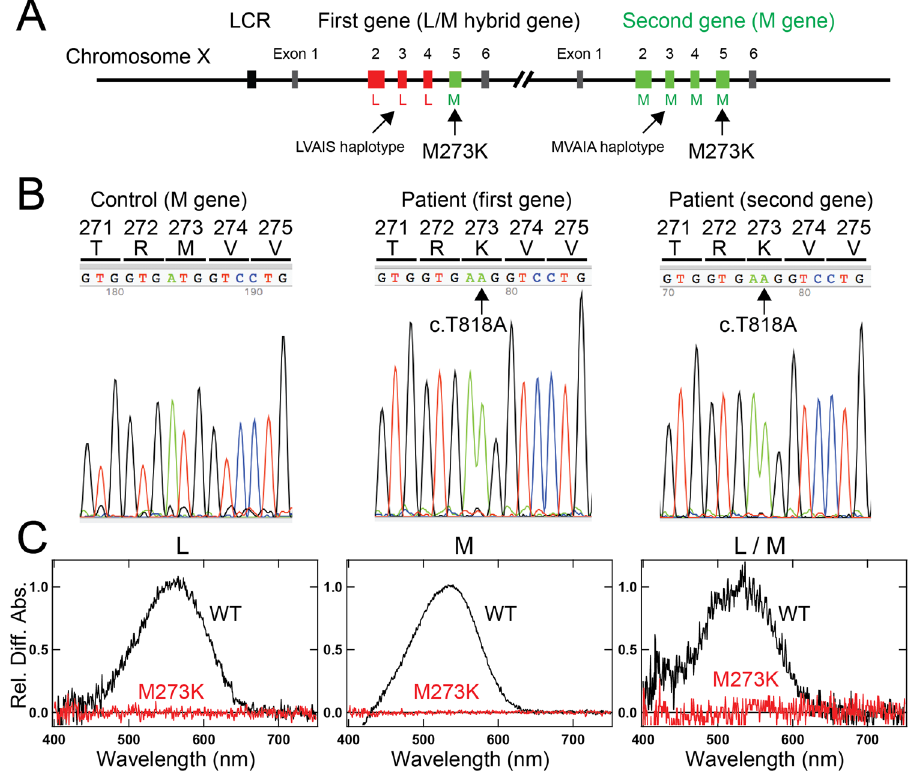
Figure 3. Genotype of Case 2. ( A ) Overview of the genotype of Case 2. Case 2 had an intact LCR and two genes. The first gene had exons 2–4 of L type, exon 3 with LVAIS haplotype, and exon 5 of M type. The second gene had exons 2–5 of M type and exon 3 with MVAIA haplotype. Both genes had the same missense mutation (c.818 T > A, M273K) in exon 5. ( B ) Partial sequence data around the missense mutation (c.818 T > A, M273K) in exon 5 in the control and two genes of Case 2. ( C ) Opsin reconstitution experiments. L, L opsin in which exons 2–5–derived amino acid sequences are all L type; M, M opsin in which exons 2–5–derived amino acid sequences are all M type, as in the product of the second gene of Case 2; L/M, M opsin in which exons 2–4– derived amino acid sequences are L type but exon 5–derived amino acid sequence is M type, as in the product of the first gene of Case 2. WT, wild-type opsin; M273K, mutant opsin with the M273K mutation. “Rel. Diff. Abs.” indicates relative difference